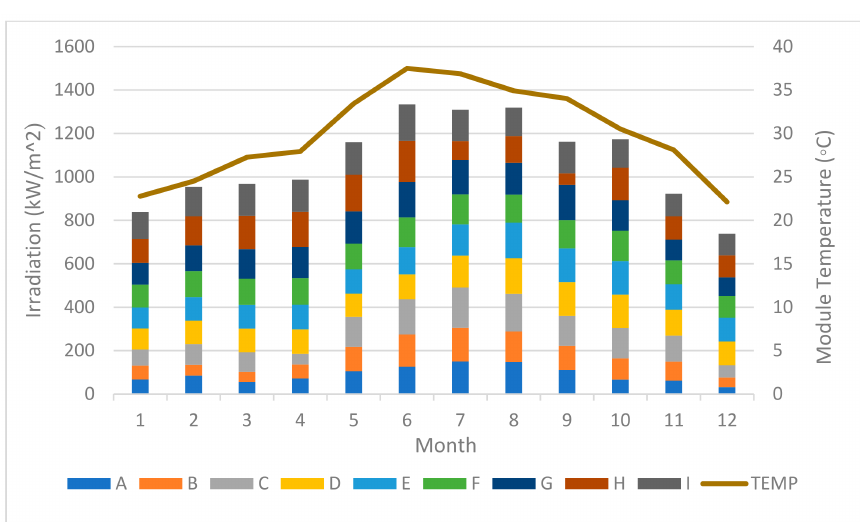
Figure 5. Accumulated solar irradiation and average module